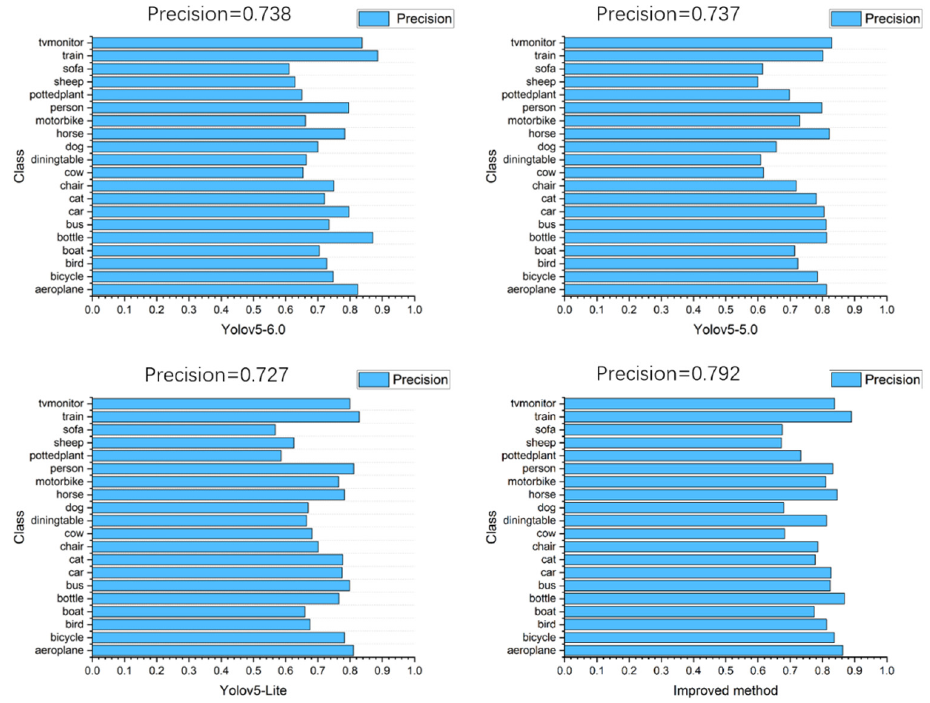
Figure 12. Precision rate of YOLOv5-6.0, YOLOv5-5.0, YOLOv5-Lite, and improved method model weights.